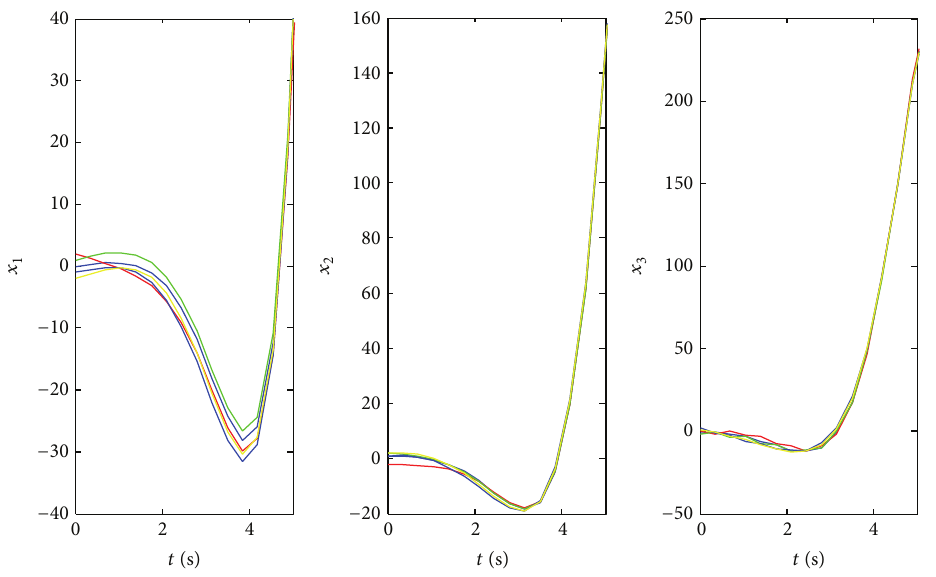
Figure 2: Trajectories of single input agents under fixed topology.